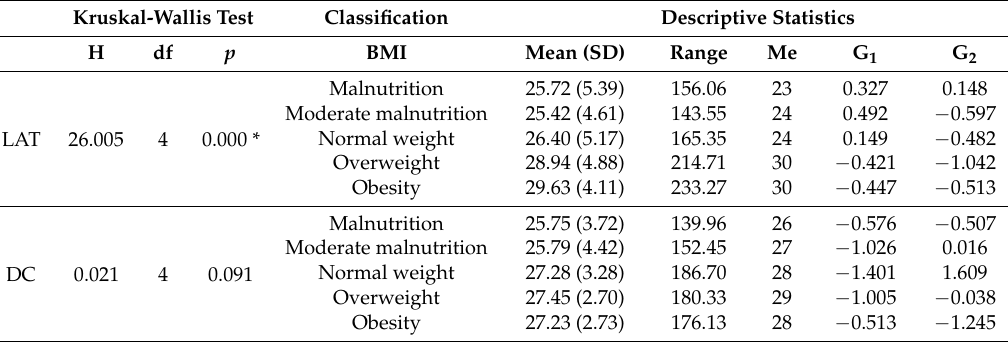
Table 4. Kruskal-Wallis test and descriptive statistics of motor skills according to BMI for the sample of